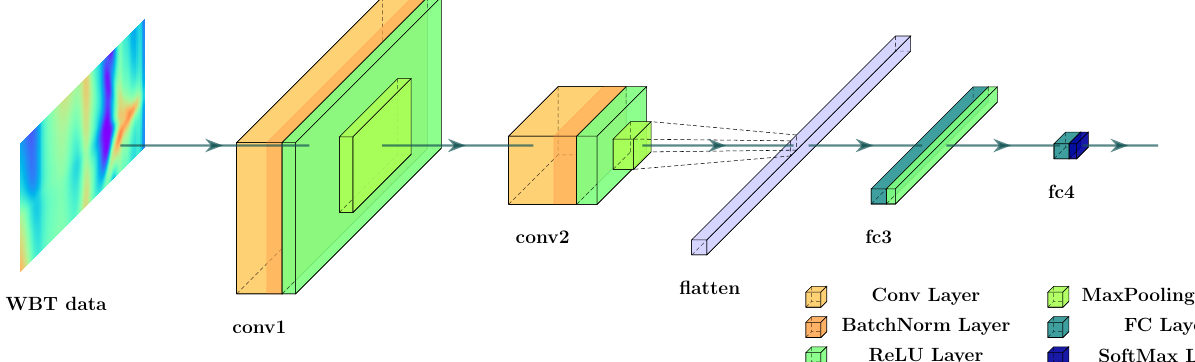
Figure 1. The adopted CNN architecture. First, conv1 and conv2 (convolution filters or feature extractors) processed the WBT image for feature extraction; then, fc3 and fc4 (classifiers) classified the features to yield the final diagnosis. The network included convolutional (Conv) layers, batch normalization (BatchNorm) layers, ReLU layers, MaxPooling layers, fully connected (FC) layers, and a SoftMax